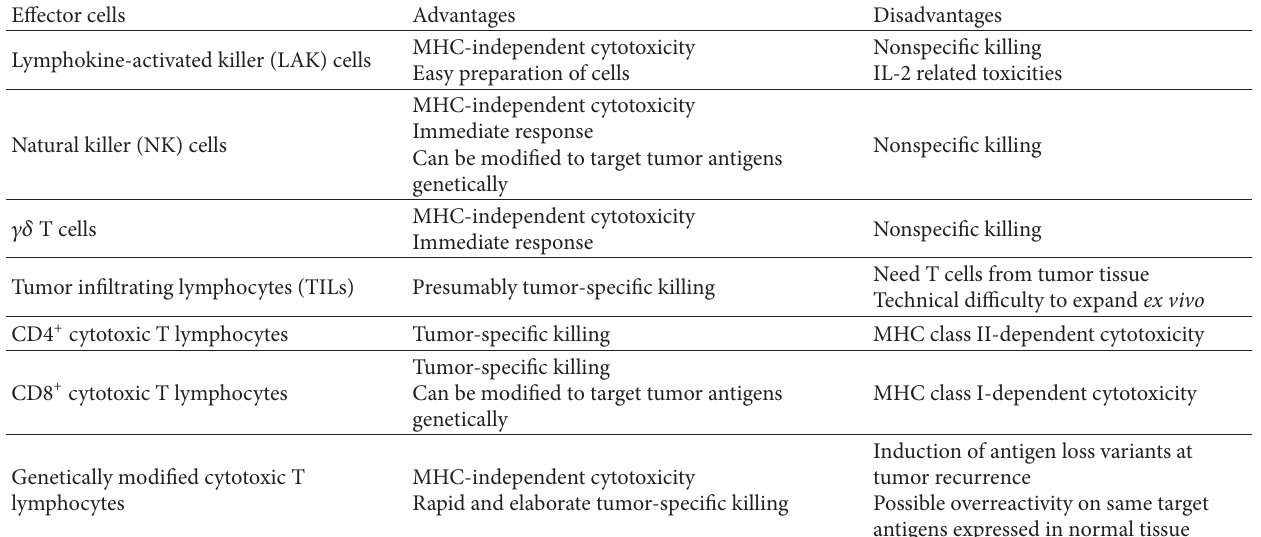
Table 2: Comparison of the effector cells used in adoptive T cell therapy for malignant